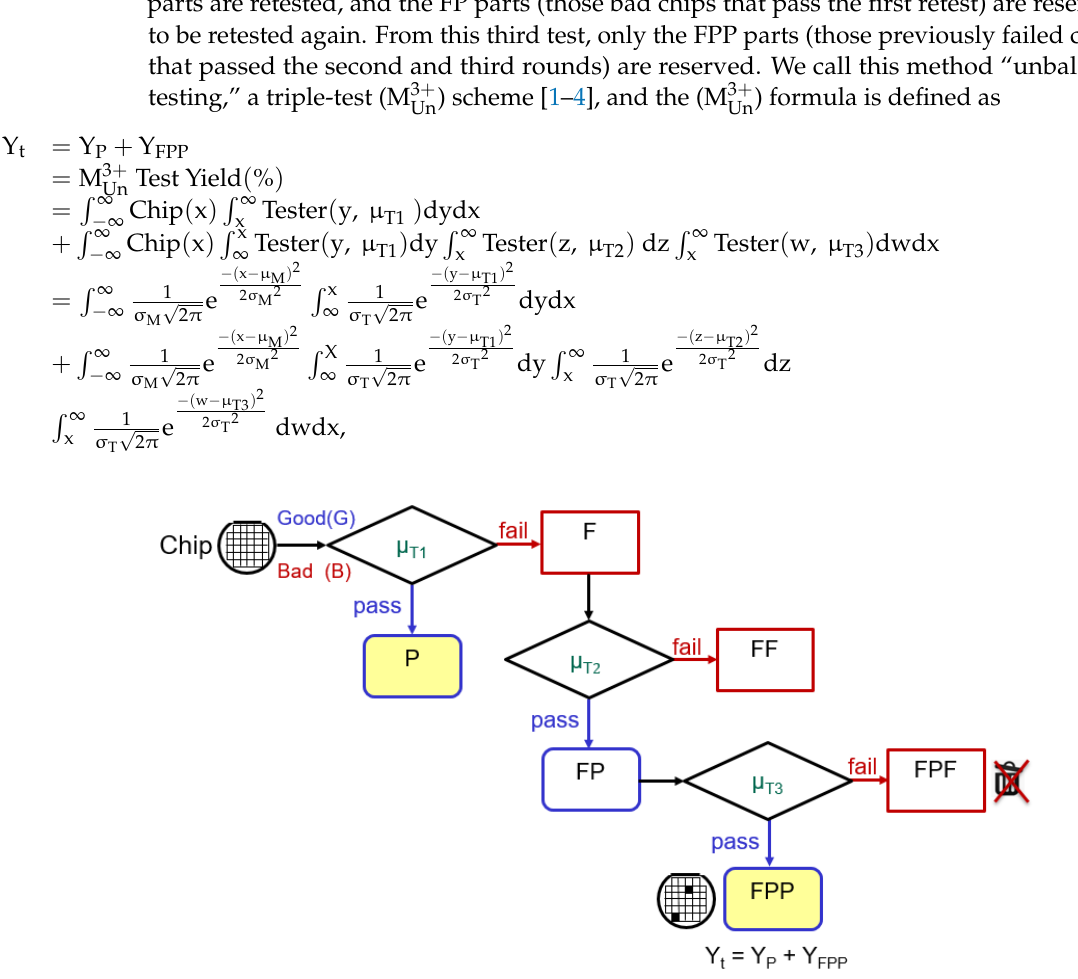
Figure 4. Proposed decision diagram for unbalanced testing ( M (cid:2905)(cid:2924)(cid:2871)(cid:2878)